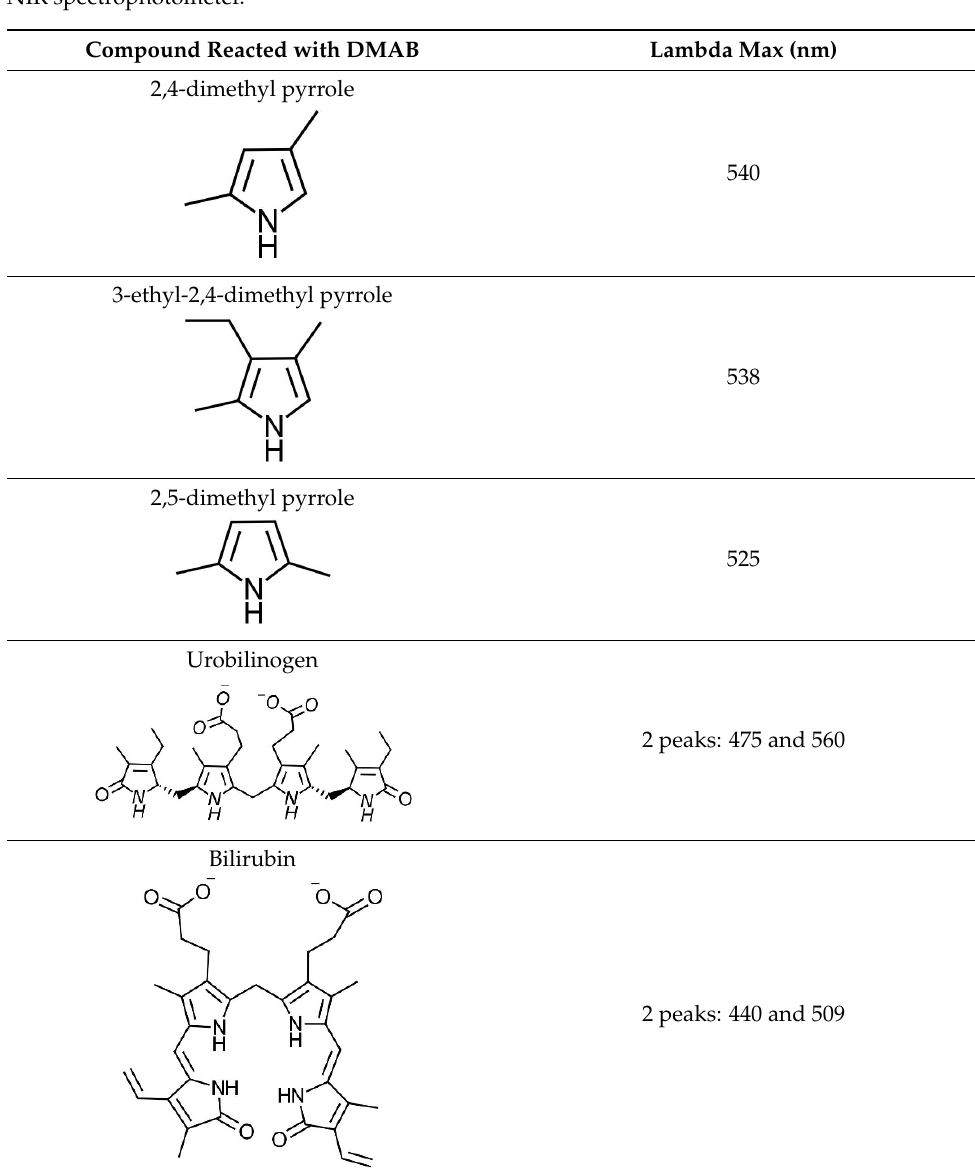
Table 1. Lambda ( λ ) max values for the complexes formed between DMAB and various pyrrole moieties. These values were determined by AAL using a GBC Cintra 2020 double beam UV-Vis NIR spectrophotometer.